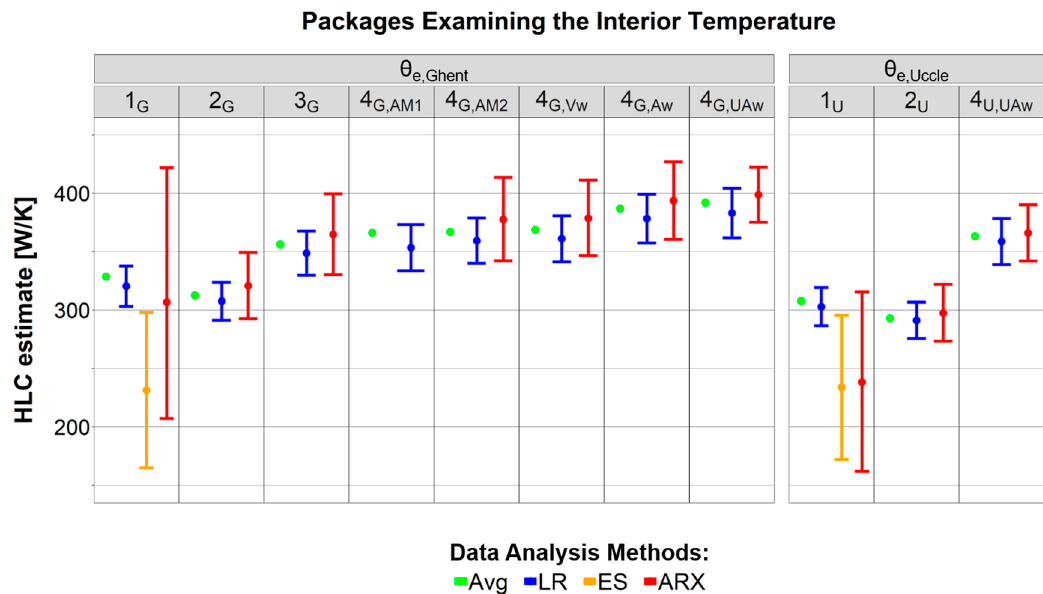
Figure 6. HLC estimates obtained by applying the Average (Avg), Linear Regression (LR) and Energy Signature (ES) method, as well as an ARX model, on the data packages investigating the influence of the considered interior temperature. The dots indicate the mean estimates, and the whiskers represent the 95% confidence intervals.